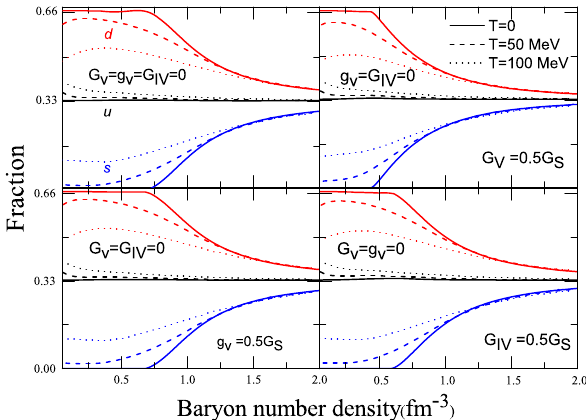
Fig. 3 Quark fraction as a function of the baryon density in SQM within the NJL model with different vector